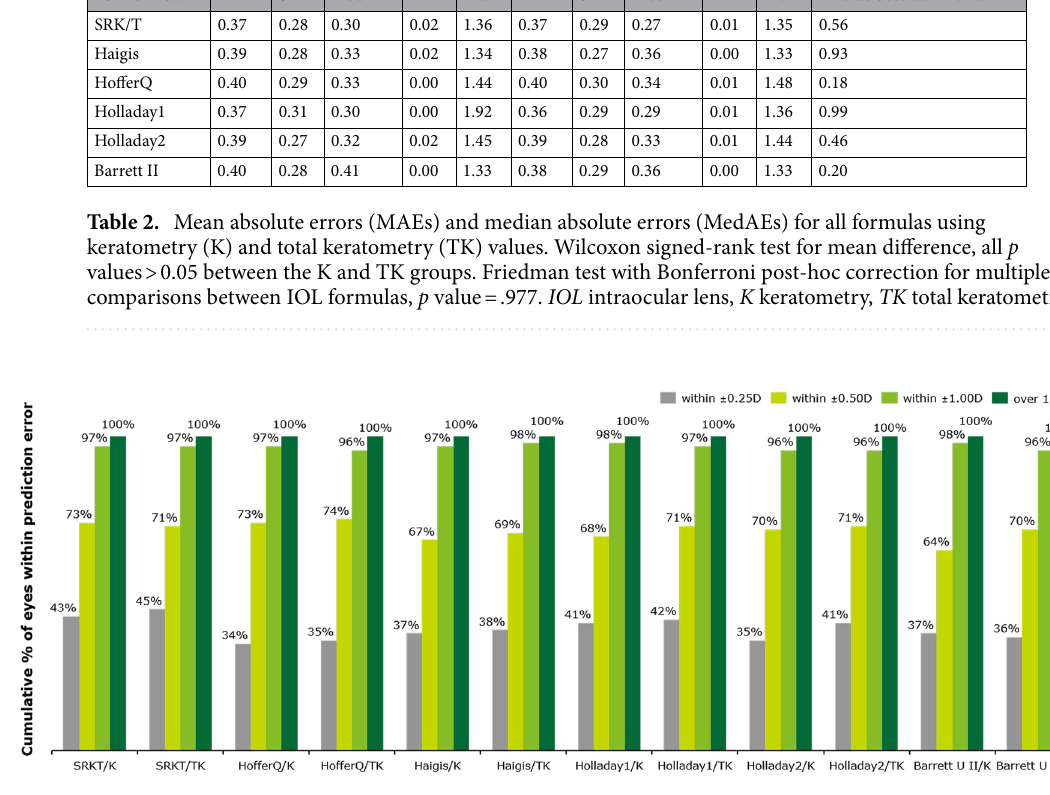
Figure 3. Stacked histogram comparing the percentages of eyes within ± 0.25 D, ± 0.50 D, and ± 1.00 D of predicted postoperative spherical equivalent refraction (SE) between all formulas using keratometry (K) and total keratometry (TK).